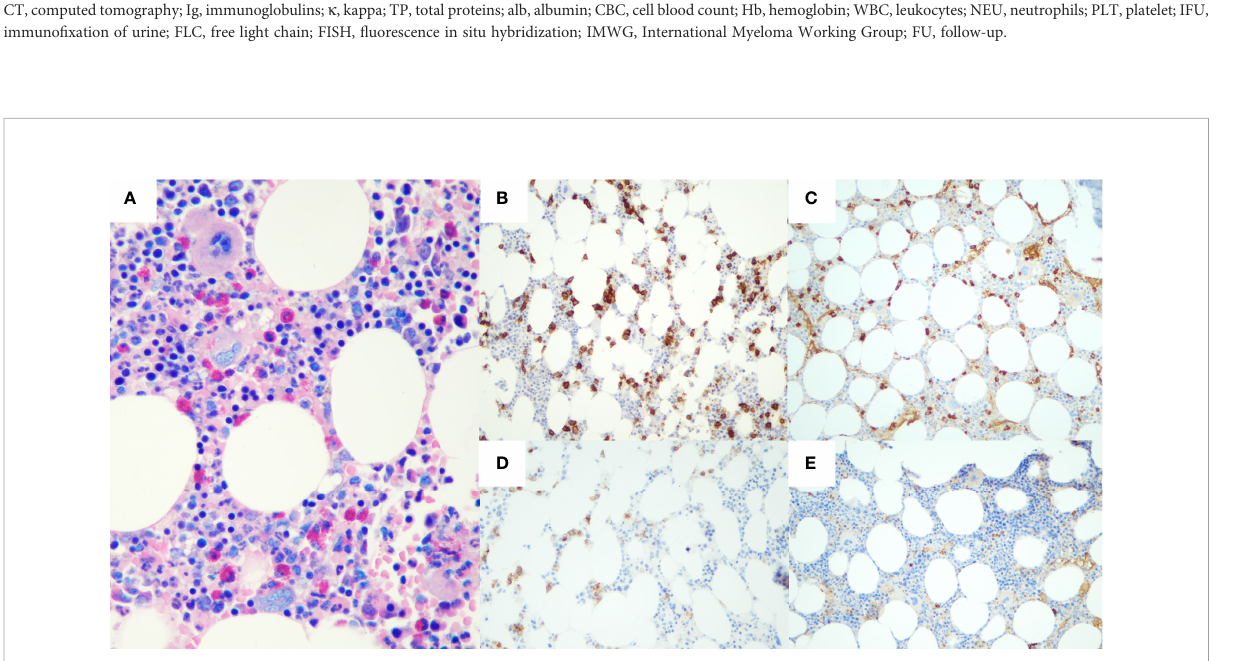
FIGURE 3 Histological and immunohistochemical features of bone marrow biopsy. Hematoxylin-eosin staining (A) shows a plasma cell in fi ltrate, accounting for 15% of bone marrow cellularity. Immunohistochemical staining presented CD138 + (B) , with restriction for Kappa light chain of Ig (C) . Neoplastic plasma cells also aberrantly expressed CD56 (D) , whereas immunohistochemistry for Lambda light chain resulted completely negative (E)